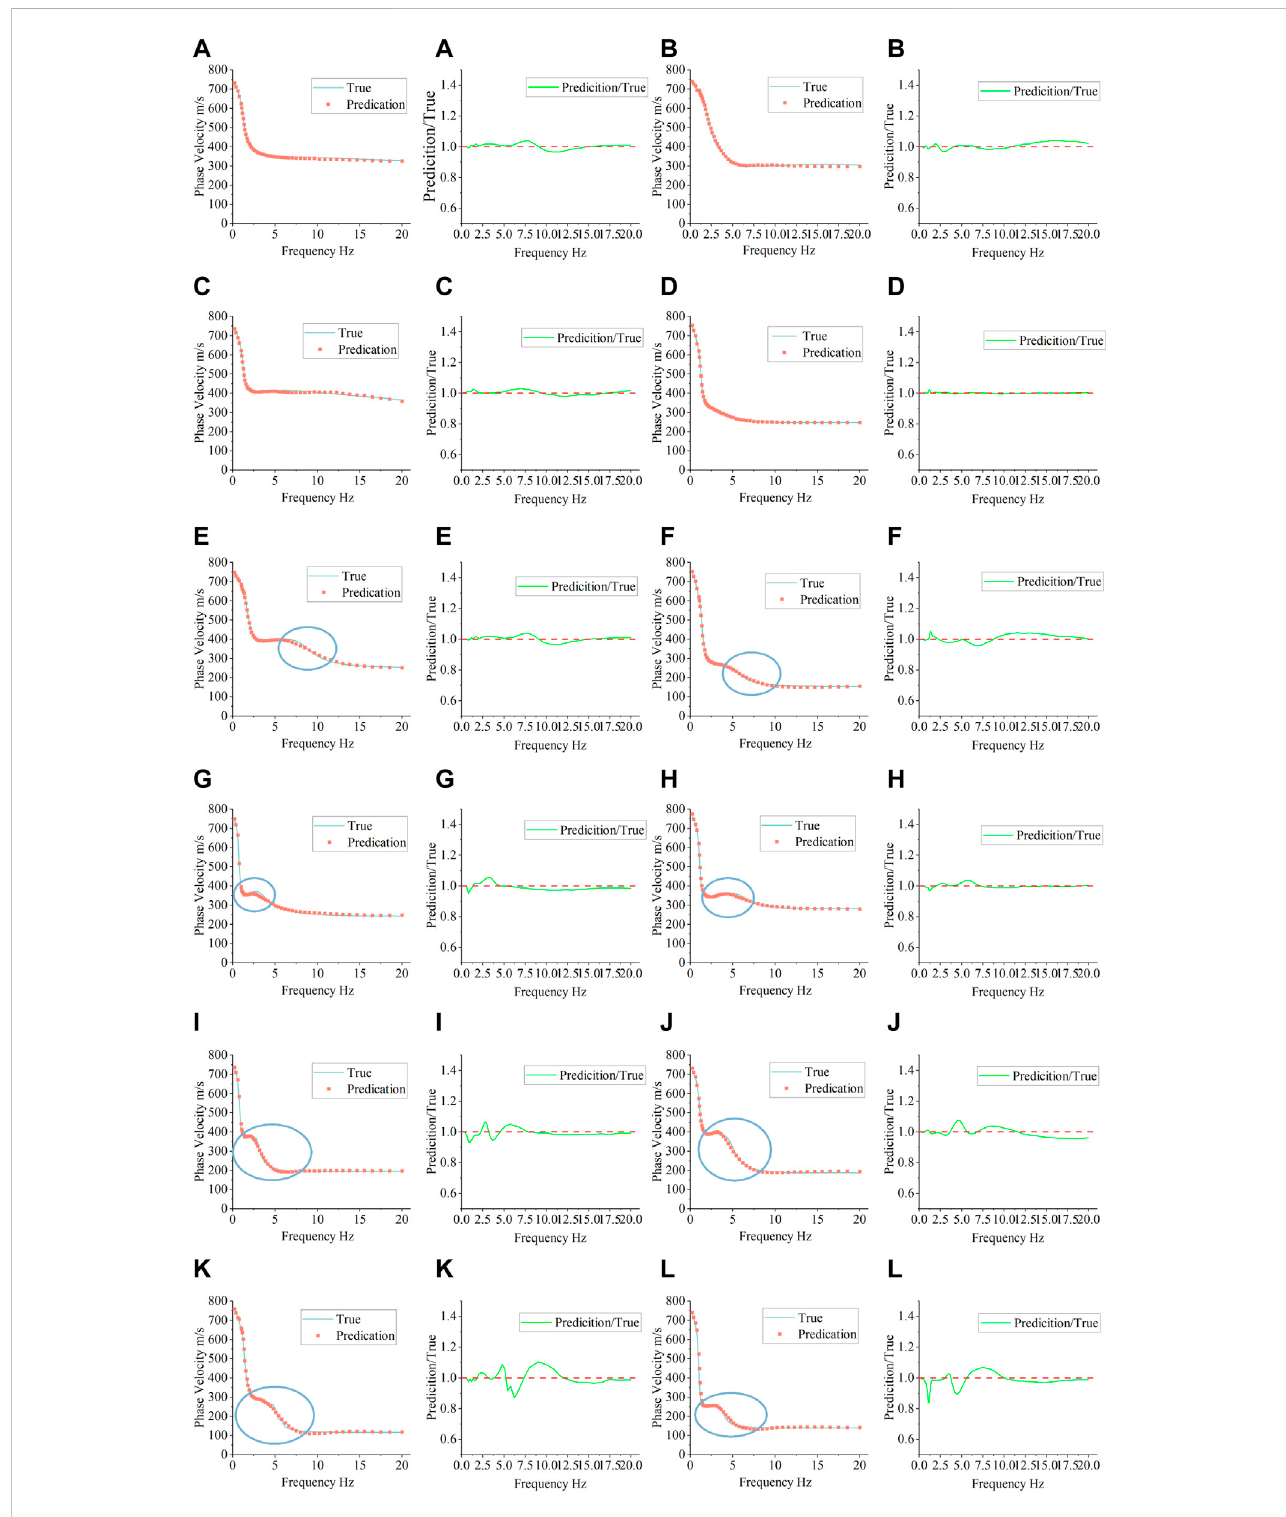
FIGURE 8 Phase velocity dispersion curve prediction and ratio